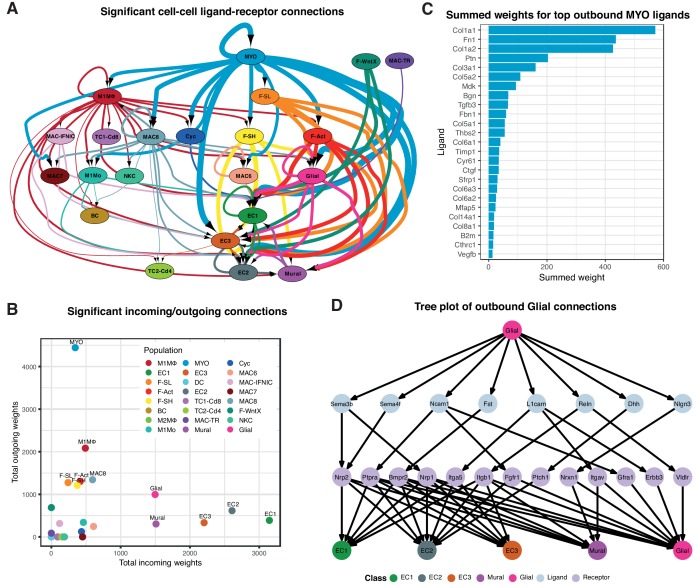
Cell-cell ligand-receptor network analysis.(A) Hierarchical network diagram of significant cell-cell interaction pathways. Arrows and edge color indicates direction (ligand:receptor) and edge thickness indicates the sum of weighted paths between populations. (B) Comparison of total incoming path weights vs total outgoing path weights across populations. (C) Summed ligand weights across souce ligand and receptor target paths for top ligands in MYO. (D) Tree plot showing outgoing connections from the Glial cells. Top node refers to source population, second layer to ligands, third layer to receptors and leaf nodes represent target populations.